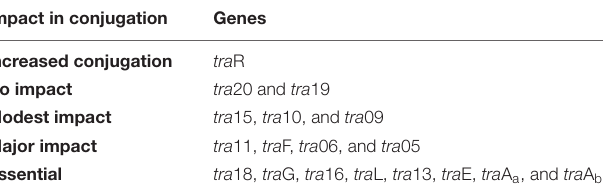
TABLE 3 | Classification of the genes from the pNP40 conjugation cluster based on their individual effect in conjugation frequency: > twofold increased conjugation, no impact in conjugation frequency; modest impact, < 10-fold decrease; major impact, up to 10,000-fold-decrease; essential for conjugation.